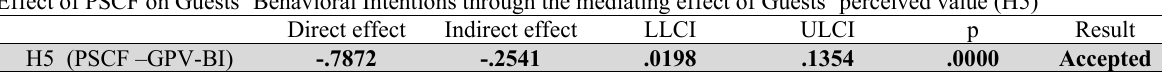
Effect of PSCF on Guests’ Behavioral Intentions through the mediating effect of Guests’ perceived value